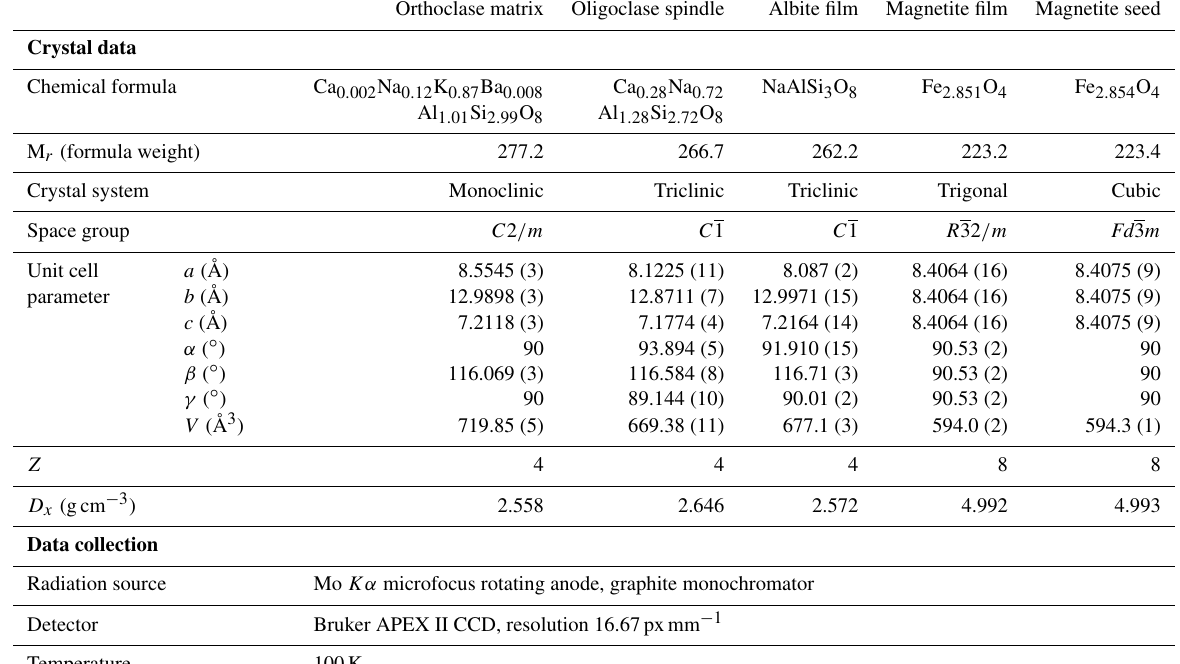
Table 3. Experimental and refinement details of the SC-XRD